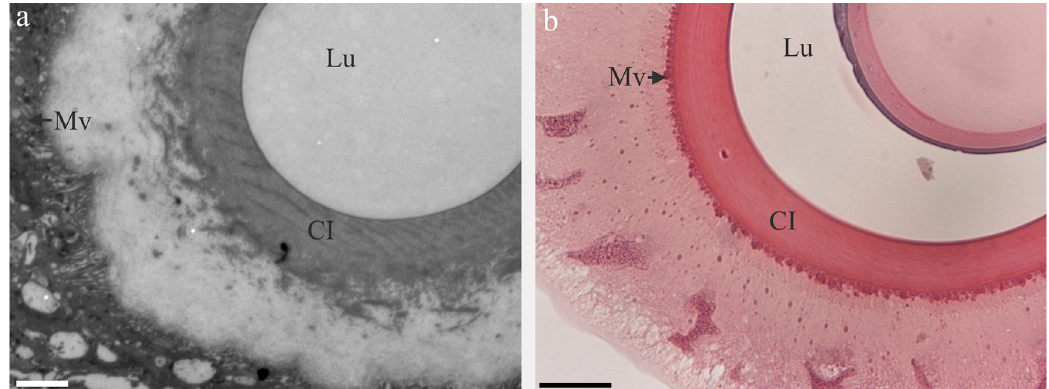
Figure 2. Transmission electron micrograph of a cross-section of the third limb of the duct of an Euprosthenops australis major ampullate gland ( a ) and a hematoxylin-eosin stained light micrograph of a cross-section of the ASG from a B. mori silk gland ( b ). Mv: microvilli, Lu: lumen, CI: Cuticular intima. Scale bars ( a ) 2 µm ( b ) 15 µm. In ( a ) the microvilli appear detatched from the cuticular intima, likely due to processing of the section for transmission electron microscopy.